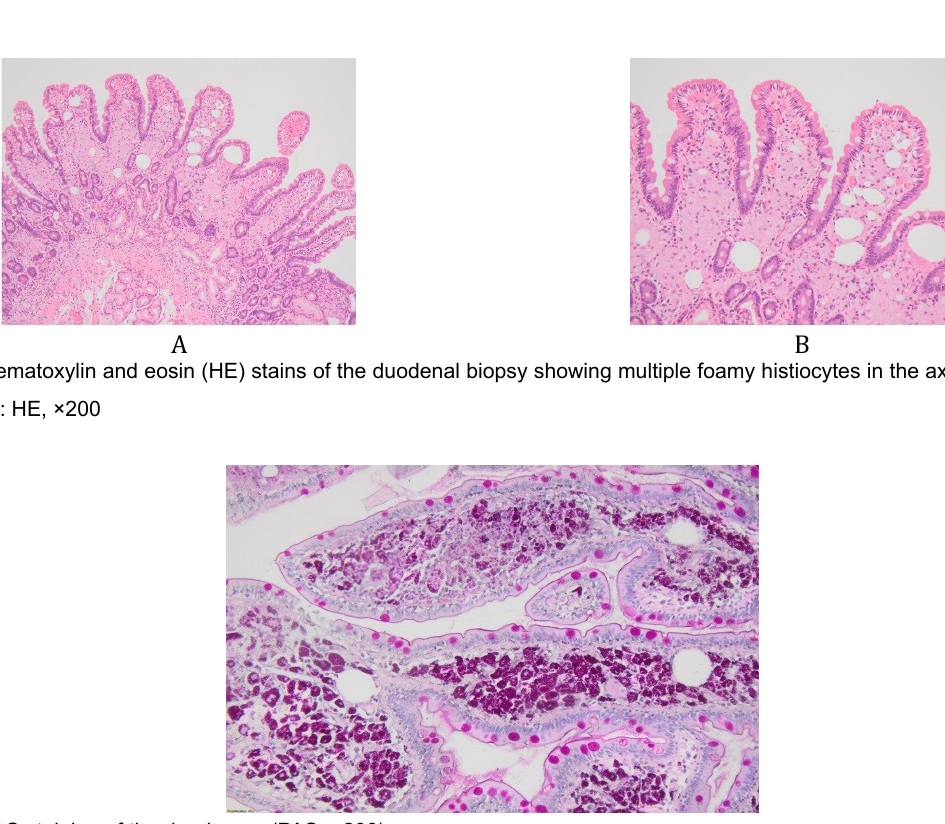
Figure 6. PAS staining of the duodenum (PAS,